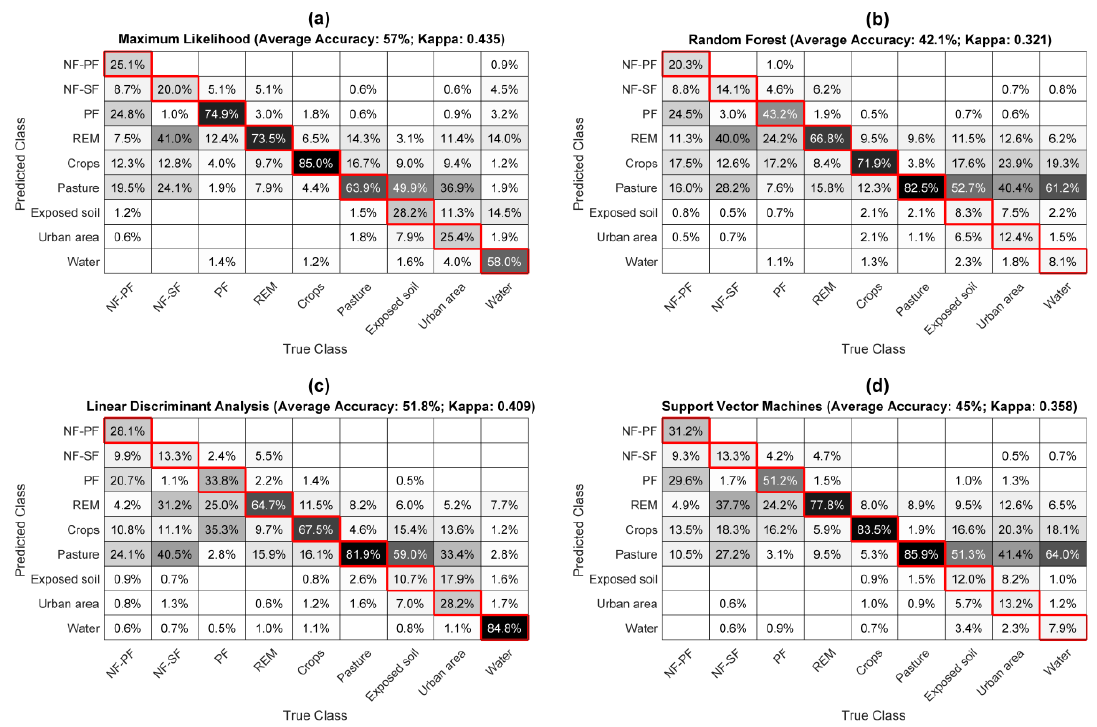
Figure A2. Confusion matrices obtained for classification maps produced by ( a ) maximum likelihood, ( b ) random forest, ( c ) linear discriminant analysis, and ( d ) support vector machines. The diagonal cells (highlighted in red) show the classification accuracy of each transition class, while the off-diagonal cells show the percentage of classification error between classes. Empty white cells refer to less than 0.5% misclassification. NF-PF = non-forest to planted forest; NF-SF = non-forest to secondary forest (successional); PF = conservation of planted forests; REM = conservation of forest remnants.